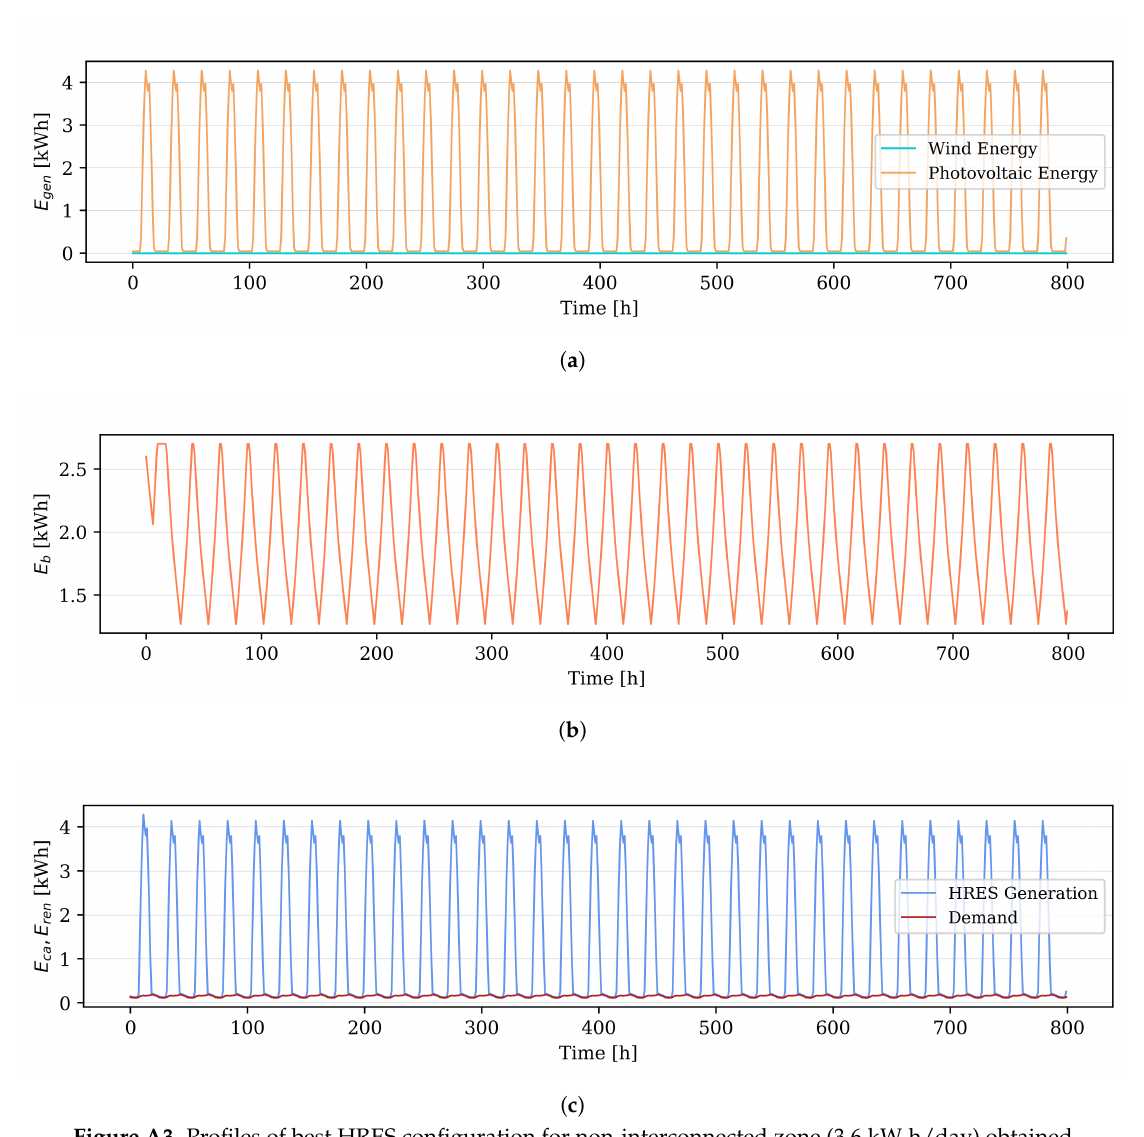
Figure A3. Profiles of best HRES configuration for non-interconnected zone (3.6 kW-h/day) obtained by multi-objective function with LCOE , N pv ,1 = 5, N pv ,2 = 9, N pv ,3 = 7, N b = 2. ( a ) Total renewable energy generation. ( b ) Storage system state. ( c ) HRES generation vs.